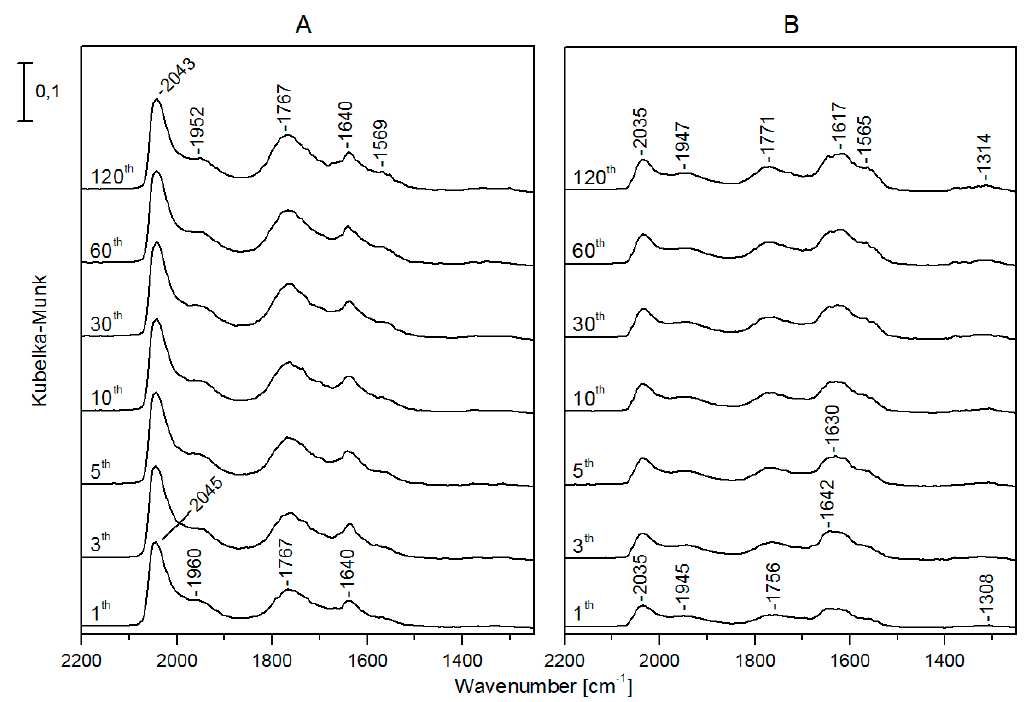
Figure 10. Infrared spectra registered during the CO 2 + H 2 reaction at 493 K on Rh/TiONT ( A ) and Au-Rh/TiONT ( B ). Spectral labels indicate the time (in minutes) passed since the beginning of the reaction.